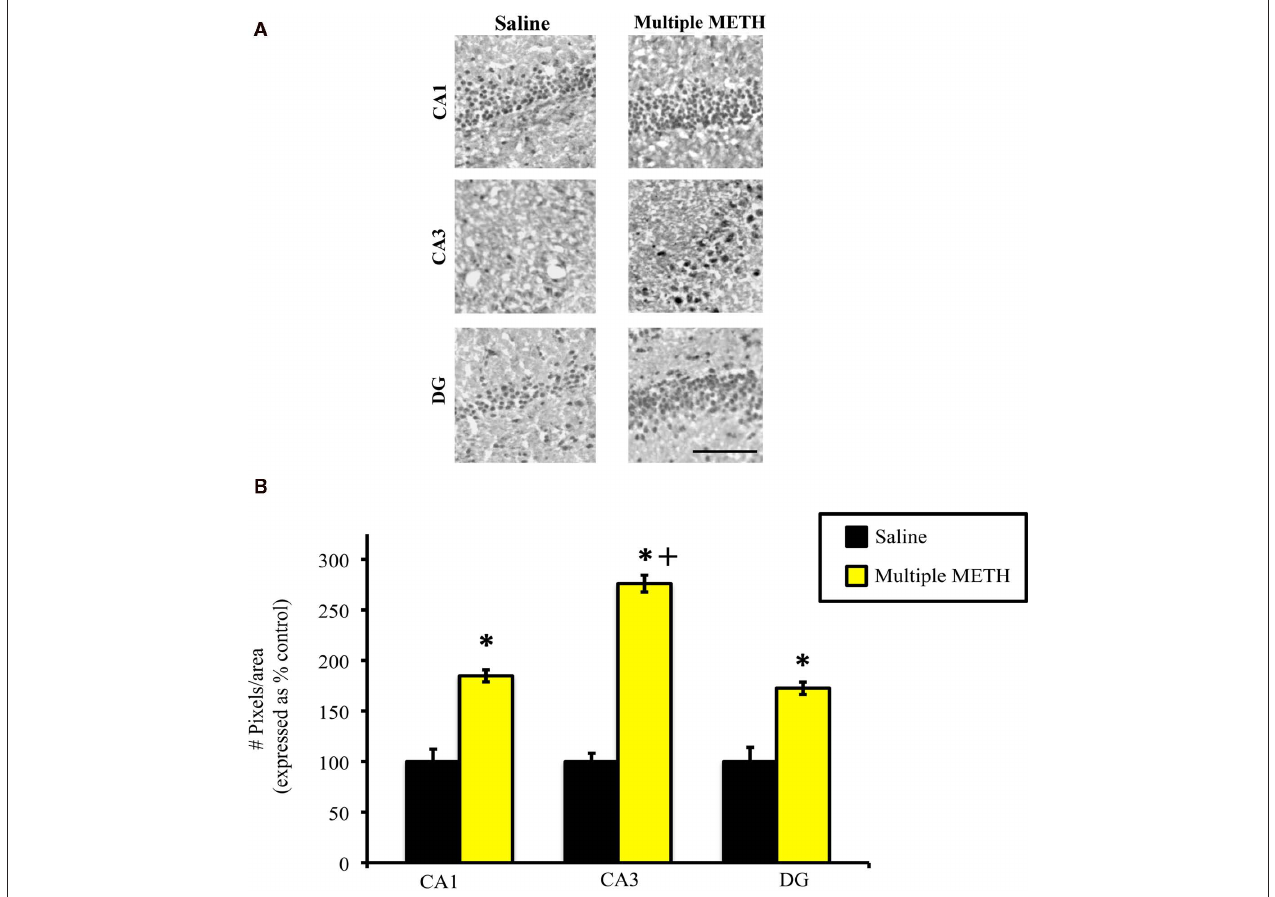
increased MDA-ir in all regions of hippocampus examined (B) . Multiple METH treatment also resulted in significantly greater MDA-ir in the CA3 sub-region of hippocampus, as compared to the CA1 and DG hippocampal sub-regions. * p < 0.05 as compared to saline-treated animals; + p < 0.05 as compared to the CA1 and DG sub-regions of hippocampus in